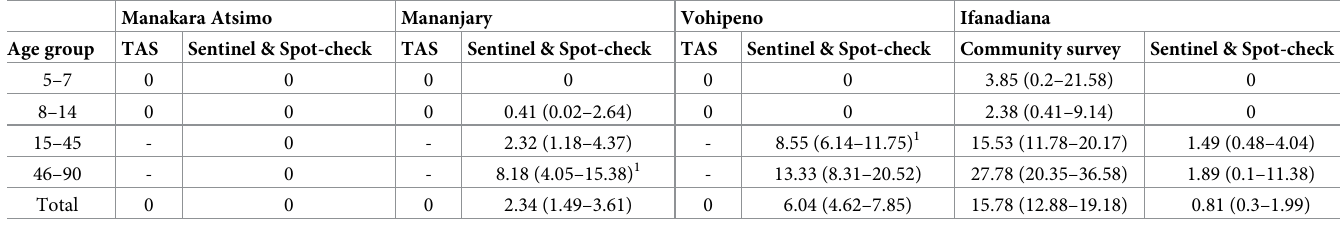
Table 3. Prevalence of lymphatic filariasis (%) in the region of Vatovavy Fitovinany in 2016, assessed by Filariasis Test Strips. Manakara Atsimo